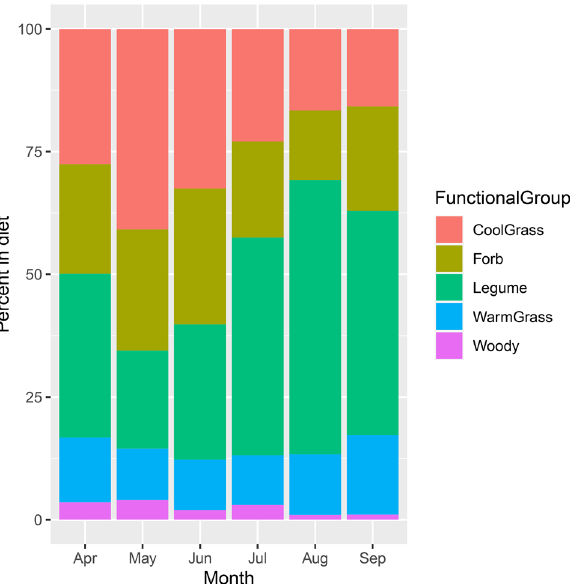
Figure 3. Average contributions of different functional groups to 2019 dietary protein intake for bison across sites for each month from April to September. Data based on the 200 most abundant Exact Sequence Variants (ESVs), which were assigned a consensus taxonomy and then a function classification. Cool-season graminoids includes C 3 grasses, sedges, and Equisetum . Warm-season grass was derived exclusively from grasses. Legumes only included species from